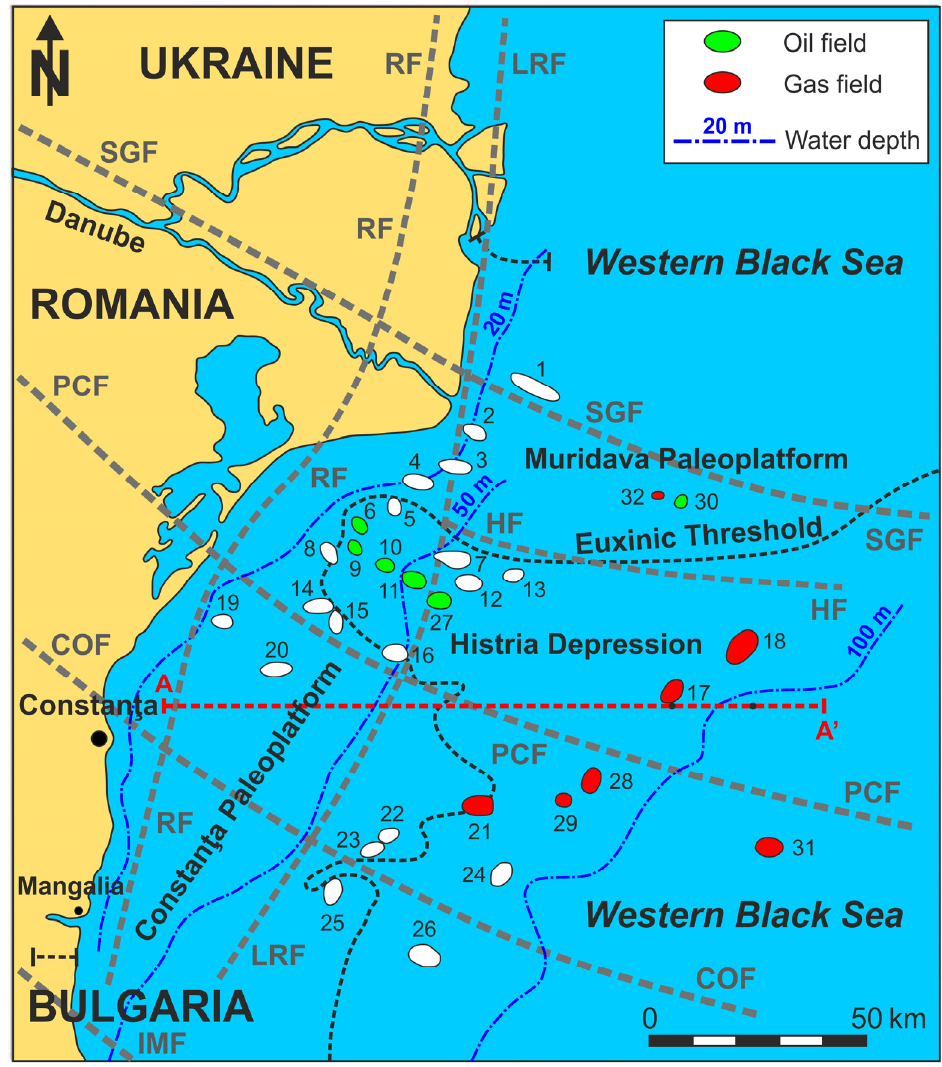
Figure 1. Simplified map of the Romanian Black Sea shelf indicating the main plays, leads and Figure 1. structural–tectonic elements. 1—Pelican, 2—Sf â ntul Gheorghe, 3—Sacalin, 4—Sturion,